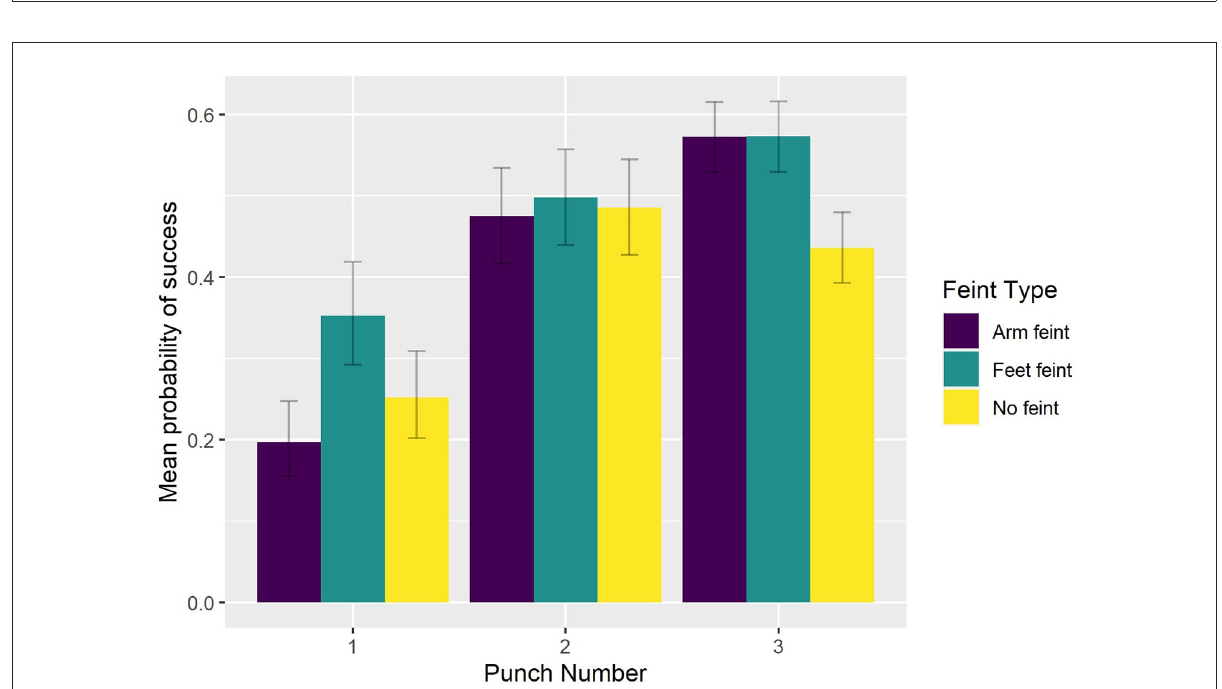
FIGURE3 Group mean probability of a successful interception as a function of Feint Type and Punch Number.